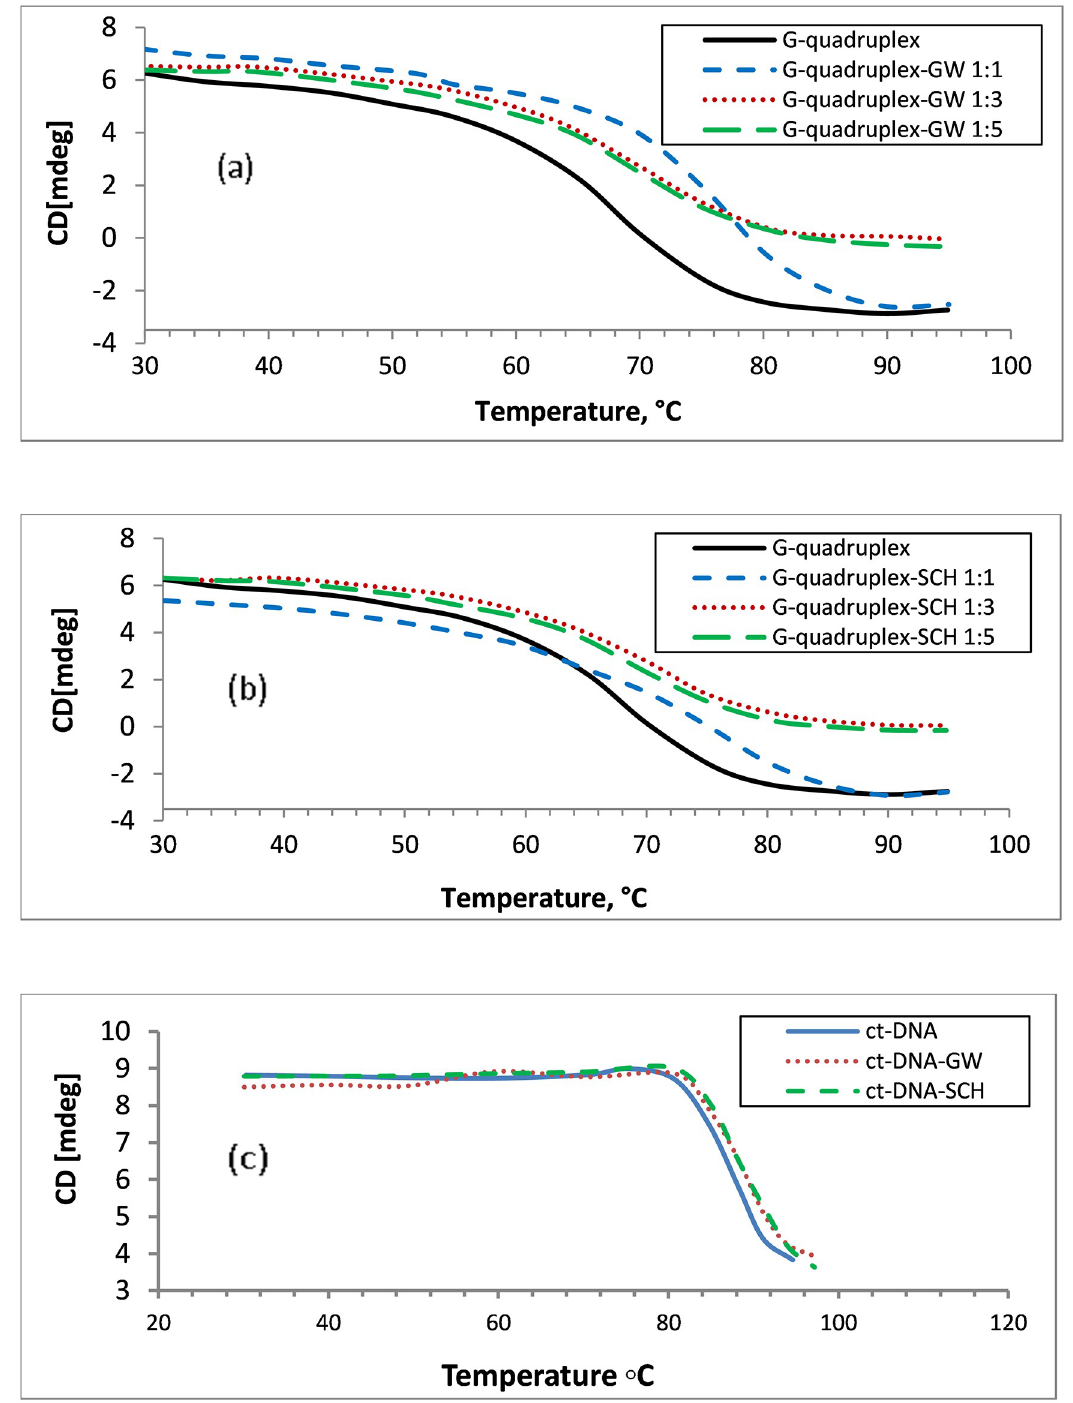
Fig 6. Melting temperature curves for human telomeric G-quadruplex DNA and its complexes with ( a ) GW-2974 and ( b ) SCH- 442416 using 1:1, 3:1 and 5:1 [(Drug)/(G-quadruplex)] molar ratios. Equimolar concentrations of 3.93 x 10 − 6 M were used. Fig 6 c shows the melting temperature curves for ct-DNA and its complexes with GW-2974 and SCH-442416. Equimolar concentrations of 1 x 10 − 9 M were used.